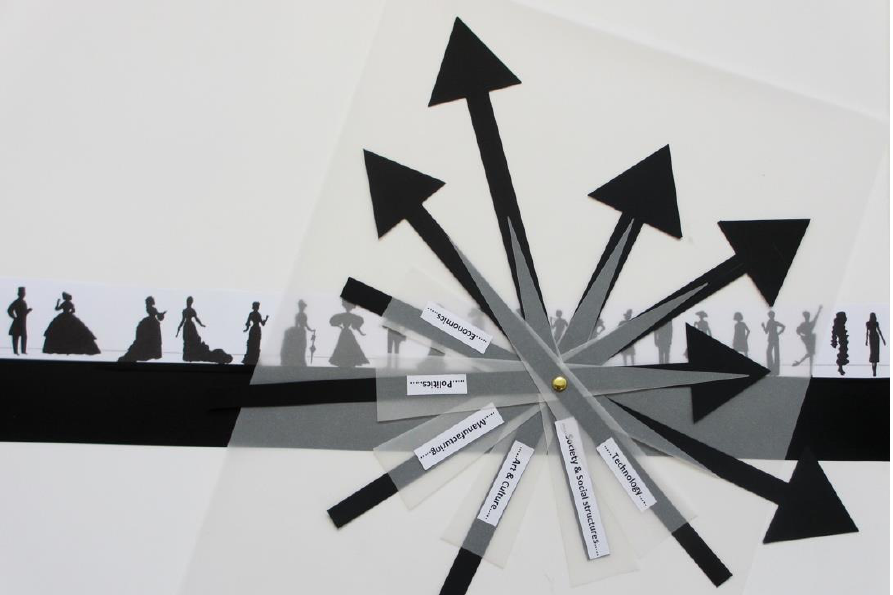
Figure 2. Fashion Timeline meets Assemblage. Rachel Matthews 2018. Example of a visual teaching resource used to introduce students to the notion of change, illustrated on the fashion timeline as a convergence of multiple timelines. The assemblage occurring at the time when these multiple trajectories intersect.